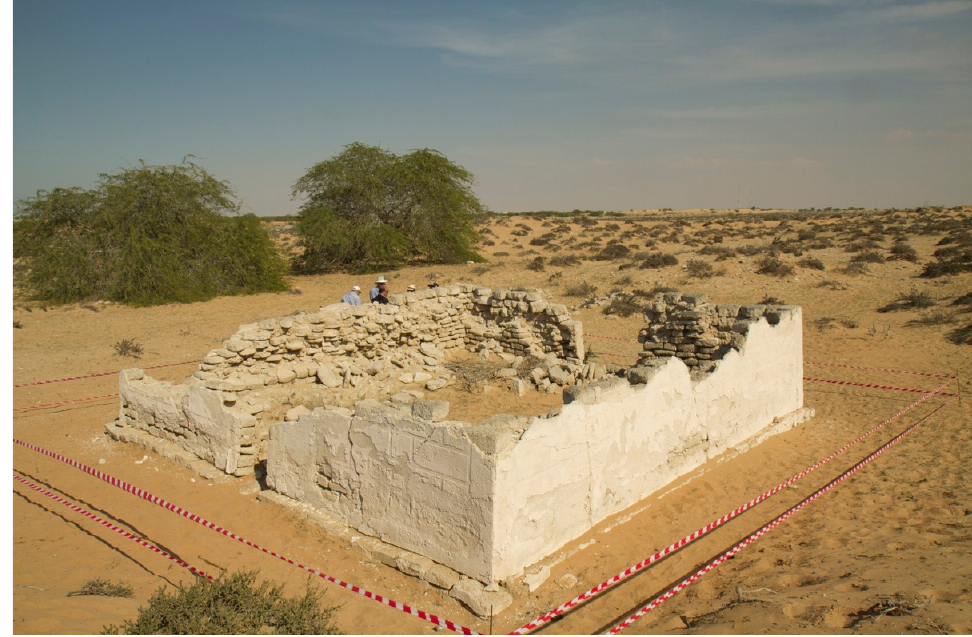
Figure 1. Temple of Shamash, at ed-Dur (Umm Al Quwain), during conservation works.